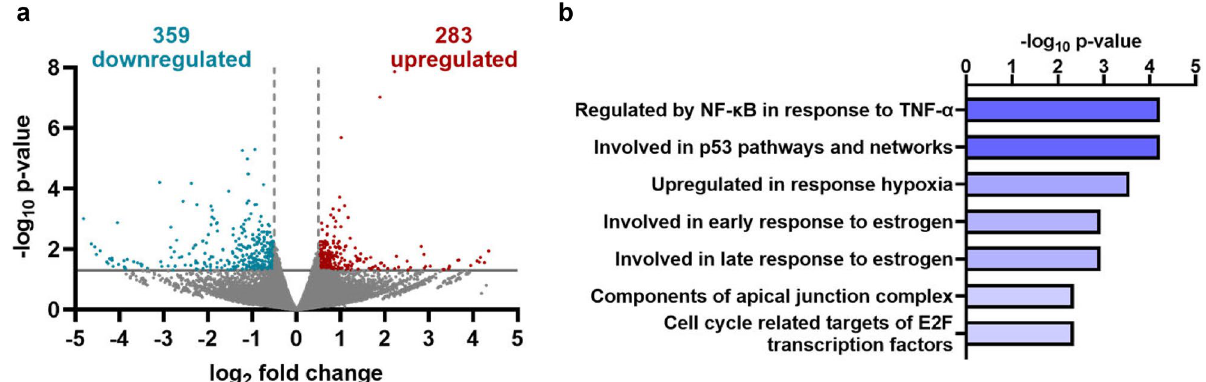
Figure 1. Altered gene expression associated with ADAR3 expression in U87 cells. ( a ) Dots represent individual genes that are downregulated (blue), upregulated (red), or not significantly different (gray) in ADAR3-expressing U87 cells compared to control U87 cells in three biological replicates of RNA-seq data. Negative log 10 p - values of differential expression (y-axis) are plotted against the average log 2 fold change in expression (x-axis). Genes considered significantly differentially expressed exhibited log 2 fold change of 0.5 (light gray broken vertical lines) and a p-value of 0.05 [log 10 p-value of 1.3, light gray horizontal line]. ( b ) Significantly enriched pathways for the 641 differentially expressed genes are listed in descending order of the -log 10 p-value provided by the Gene Set Enrichment Analysis computational